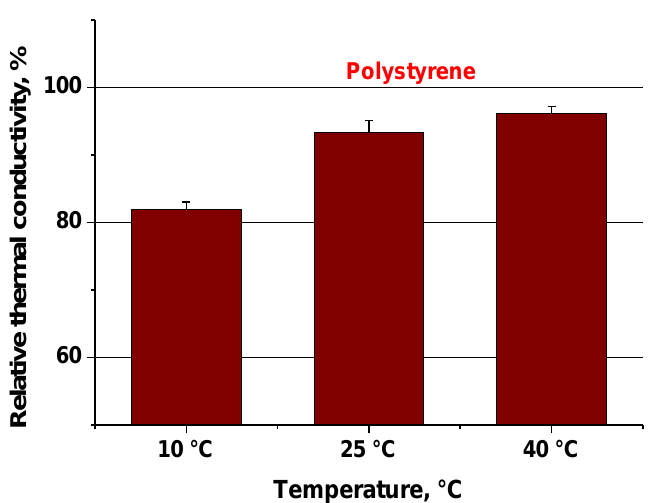
Figure 9. Relative thermal conductivity of bio-polymer composite.